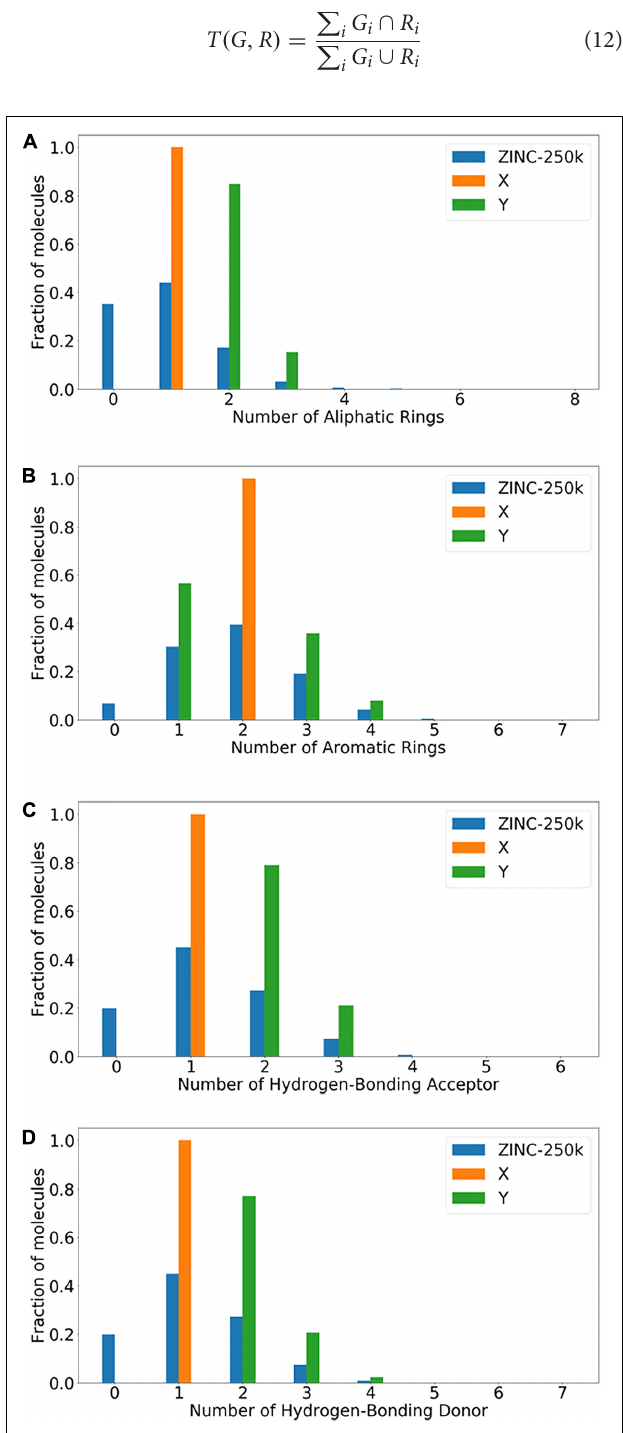
FIGURE 3 | ZINC-250K data sets are distributed according to specified four characteristics. (A) Aliphatic Rings; (B) Aromatic Rings; (C) Hydrogen-Bonding Acceptor; (D) Hydrogen-Bonding